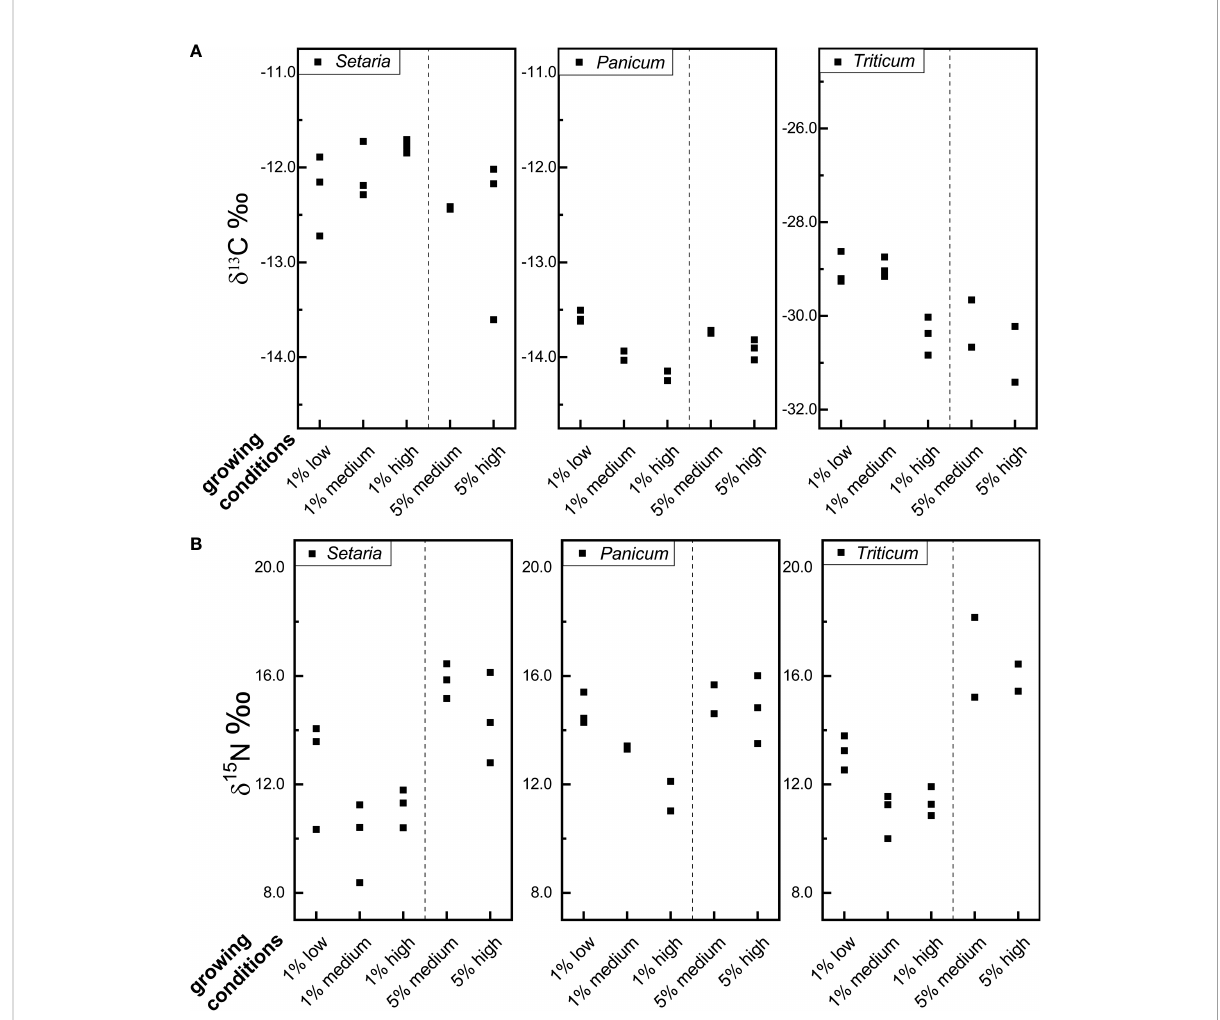
FIGURE 1 The carbon (A) and nitrogen isotope values (B) of foxtail millet ( Setaria italica ), broomcorn millet ( Panicum miliaceum ) and wheat ( Triticum aestivum ) grains grown under different manuring and watering conditions (for growing conditions, 1% and 5% are referring to the manuring levels, and low, medium, and high are referring to watering levels, for example, ‘ 1% low ’ represents ‘ 1% manuring + low watering level ’